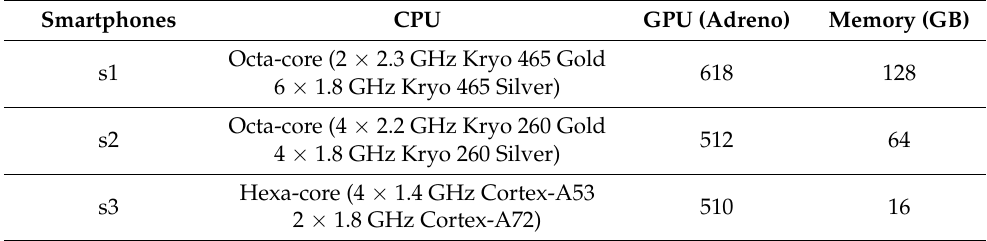
Table 2. The specifications of the smartphones used in the experiments.